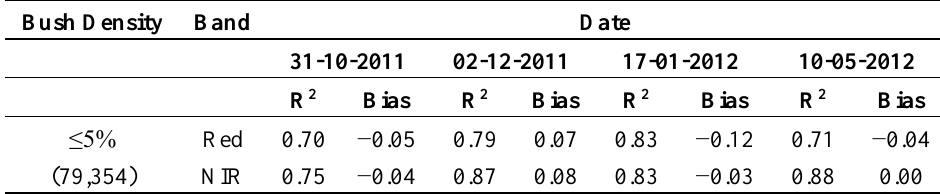
Figure 5. Time series of MODIS (green), RapidEye (blue) and ESTARFM (red) reflectance for the red ( left column ) and near-infrared ( right column ) band for those pixels falling into MODIS pixel size extents classified as “Less than 5% bush density”. Table 3. Pixel based regression of the observed RapidEye scenes against the correspondent ESTARFM predicted images for Subset 1, summarized for bush cover classes. The bias is given as its value relative to the mean value of the observed image. Numbers in brackets show number of pixels at RapidEye